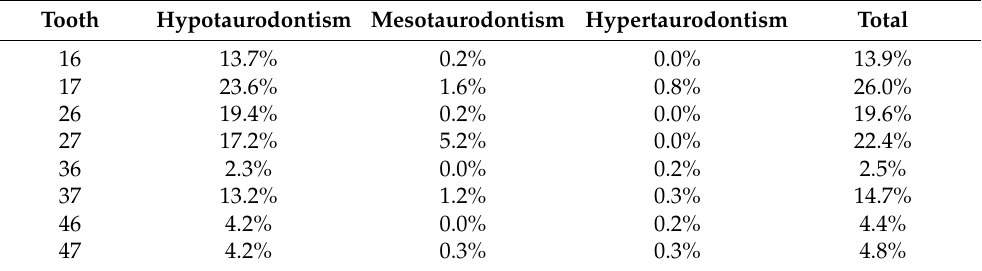
Table 3. The frequency of hypotaurodontism, mesotaurodontism, and hypertaurodontism in every